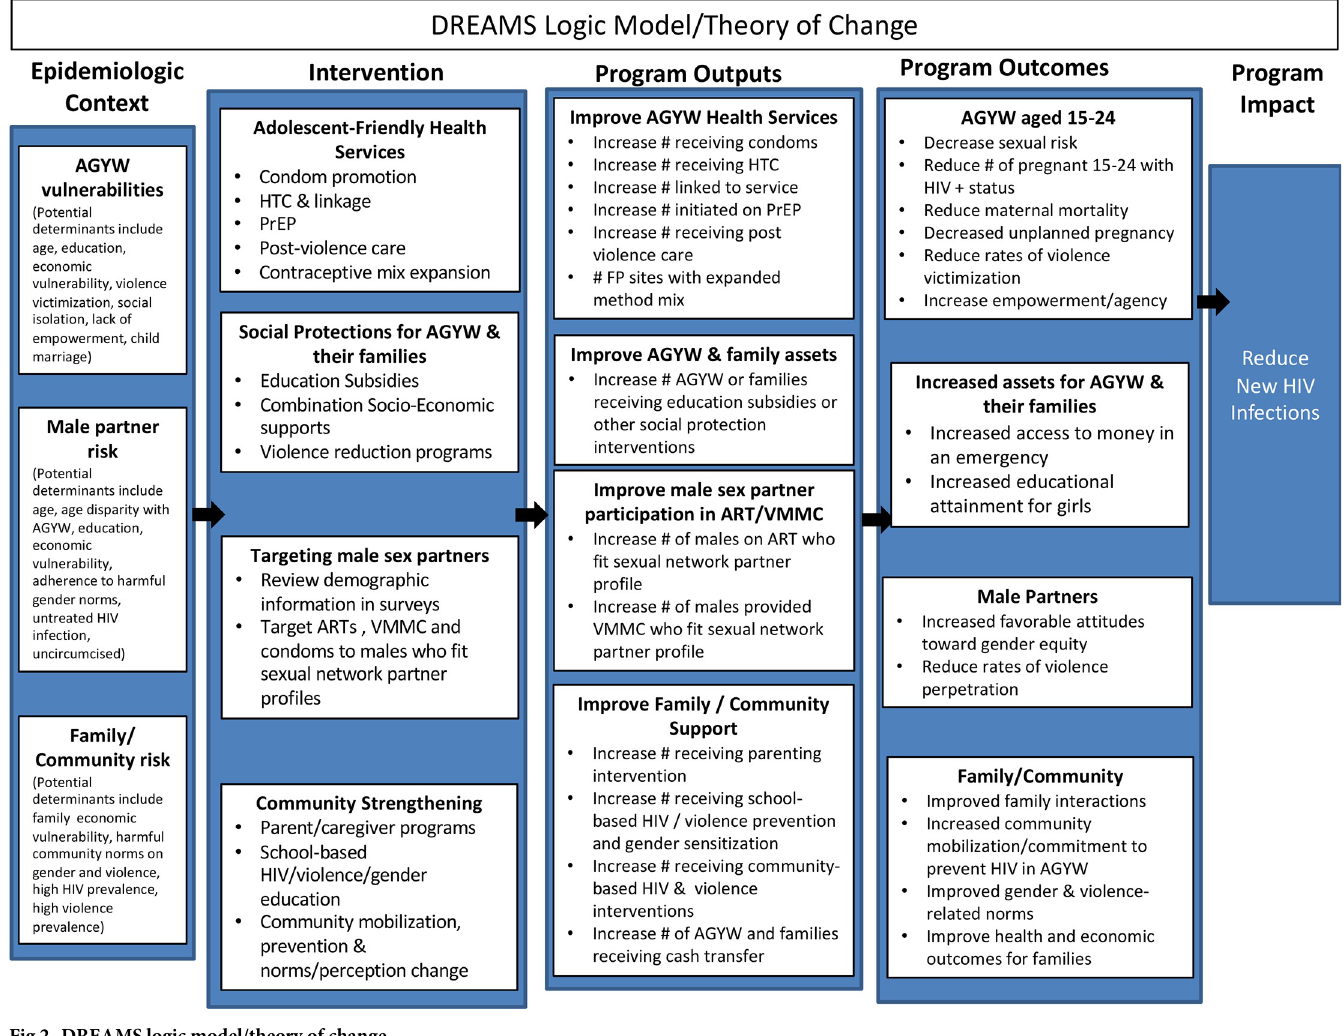
Fig 2. DREAMS logic model/theory of